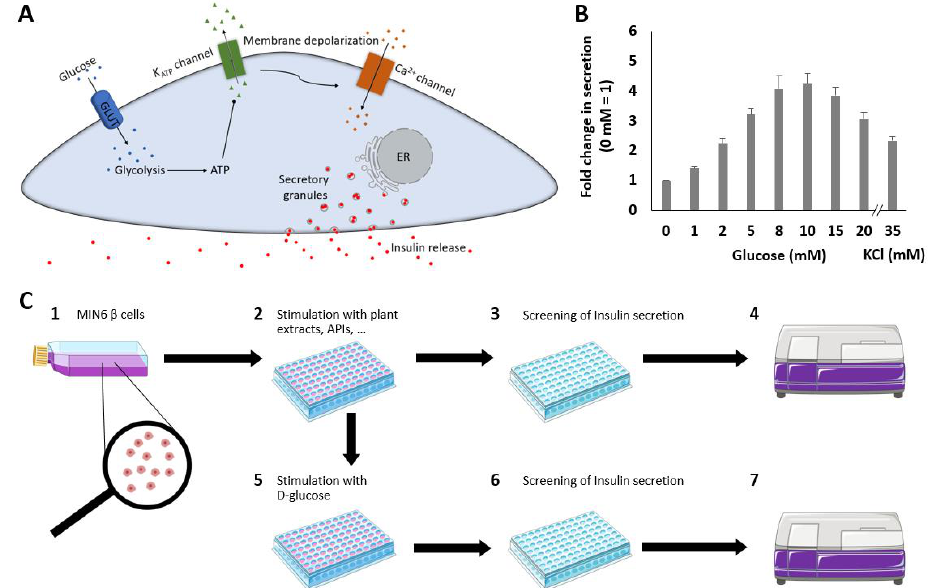
Figure 1. Schematic overview of the GSIS pathway from pancreatic β cells that produce and secrete insulin in response to changes in ambient blood glucose concentrations. Glucose enters the cell via the glucose transporter GLUT2 and is metabolized to pyruvate and ATP. The generated ATP binds to and closes ATP-dependent potassium channels (K ATP channels). Due to channel closure, potassium exit is blocked, resulting in depolarization of the cell membrane. Voltage-gated calcium channels are thus triggered, and an influx of calcium occurs. The elevated cytoplasmic calcium concentration triggers the release of insulin and C-peptide in equimolar amounts ( A ). Insulin secretion depending on different glucose concentrations in MIN6 β cells and in response to 35 mM KCl. Fold changes in the secreted luciferase activity expressing Ins-GLuc normalized to the activity of 0 mM glucose and expressed as fold change ± SEM. Data are the average of at least three independent experiments with a minimum of 17 replicates in total ( B ). Schematic overview of the insulin secretion stimulation and suppression assay ( C ). MIN6 β cells were cultured in flasks or dishes, trypsinized, counted and diluted in cell culture media (1). Cells (200 µL) were aliquoted into wells of a 96-well plate and cultured before washing and starving in KRPH buffer and incubation with plant extracts (2). Fifty microliters of supernatant were removed, pipetted into a white 96-well plate and mixed with working solution (3). Luminescence was measured immediately after pipetting (4). To test the suppression of insulin secretion of the plant extracts, 10 mM glucose was added (5) after incubation with different plant extracts (2). Assay preparation and measurements (6, 7) were performed as described previously (3, 4).